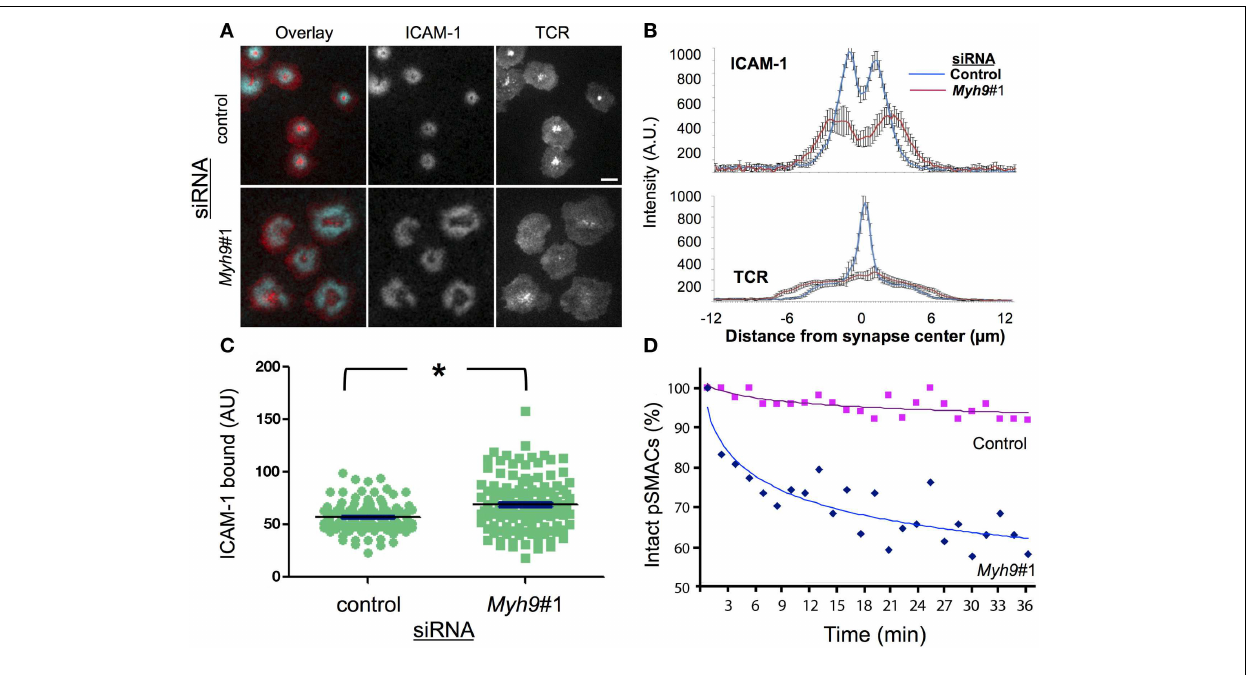
ICAM-1 accumulation in the immunological synapse of cells treated with control (green circle) or Myh9 #1 (green square) siRNA at 30min * p < 0.001. (D) Time-dependent symmetry breaking of ICAM-1 accumulation in control (red squares) and Myh9 #1 (red) (blue diamonds) siRNA-treatedT cells.This experiment was repeated